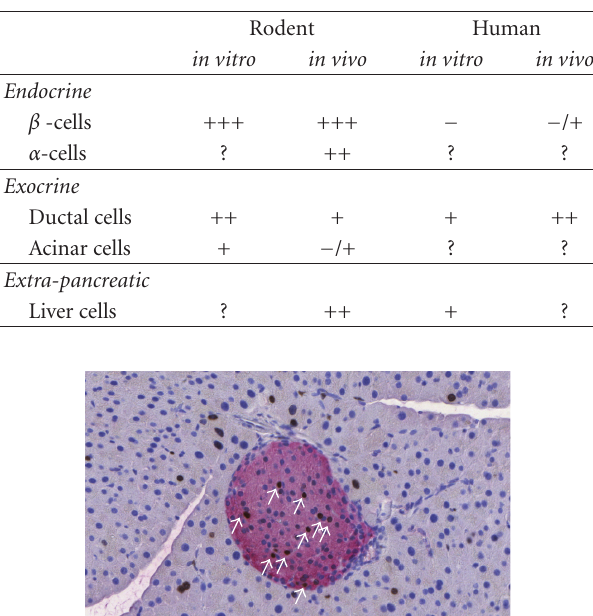
Table 1: Potential sources of de novo β -cells among di ff erentiated adult cell types.